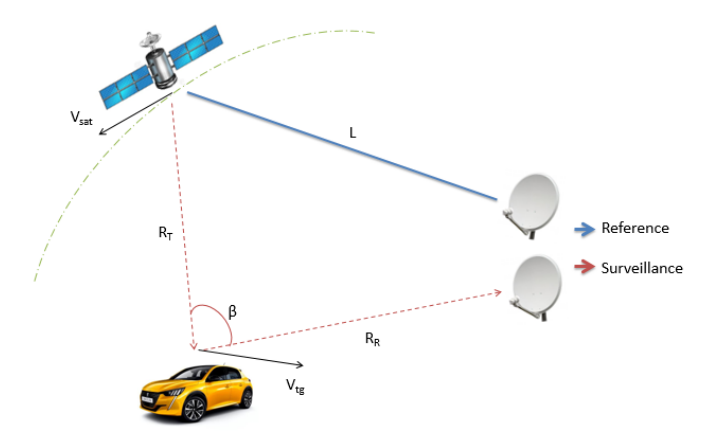
Figure 1. Basic geometry of a satellite IoO-based passive